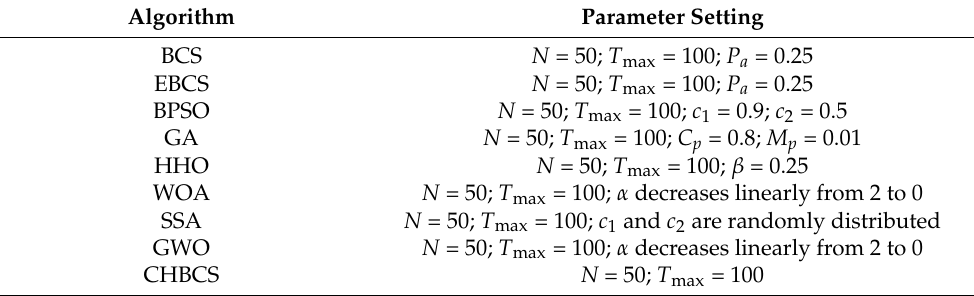
Table 5. Parameter settings.